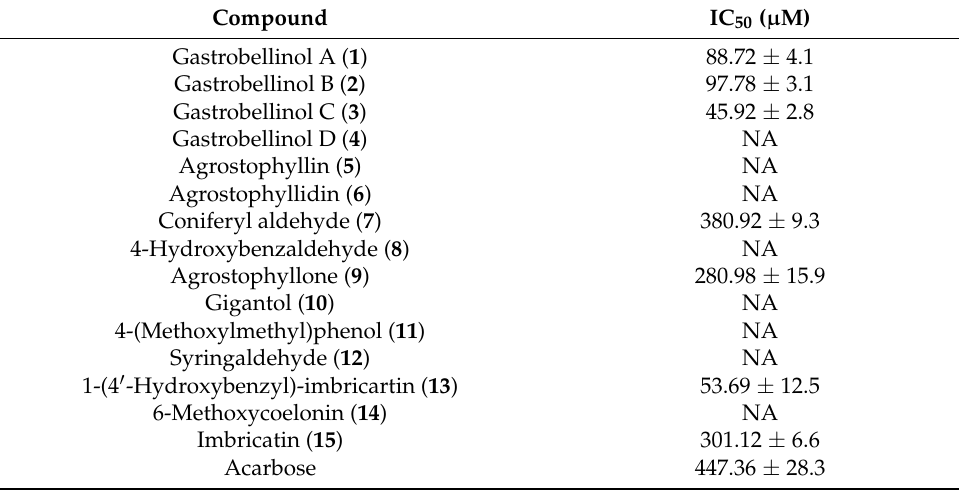
Table 3. α -Glucosidase inhibitory activity of compounds 1 – 15